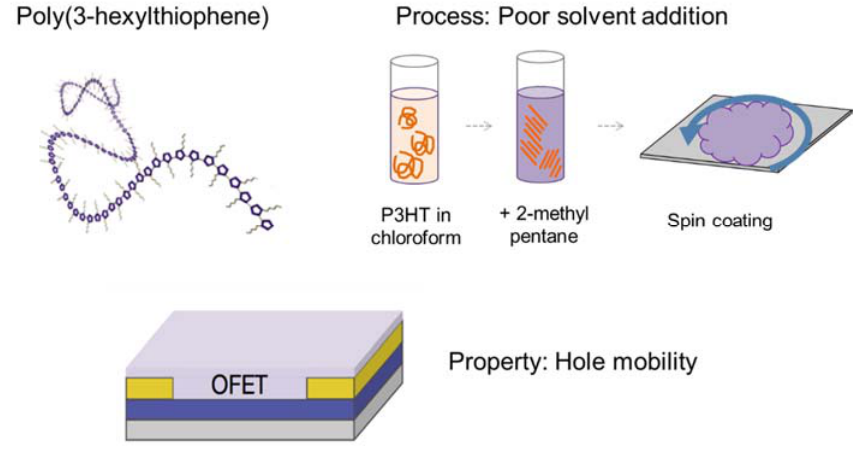
Figure 2. One possible processing route for poly-3-hexylthiophene (P3HT), and a key property of interest in organic field-effect transistor (OFET) performance.